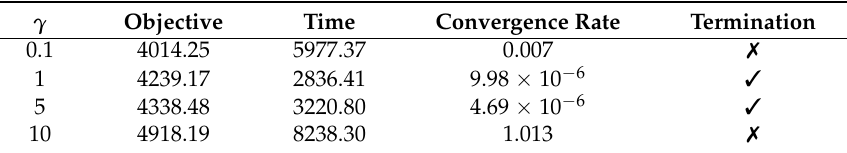
Table 3. Termination results of PH.